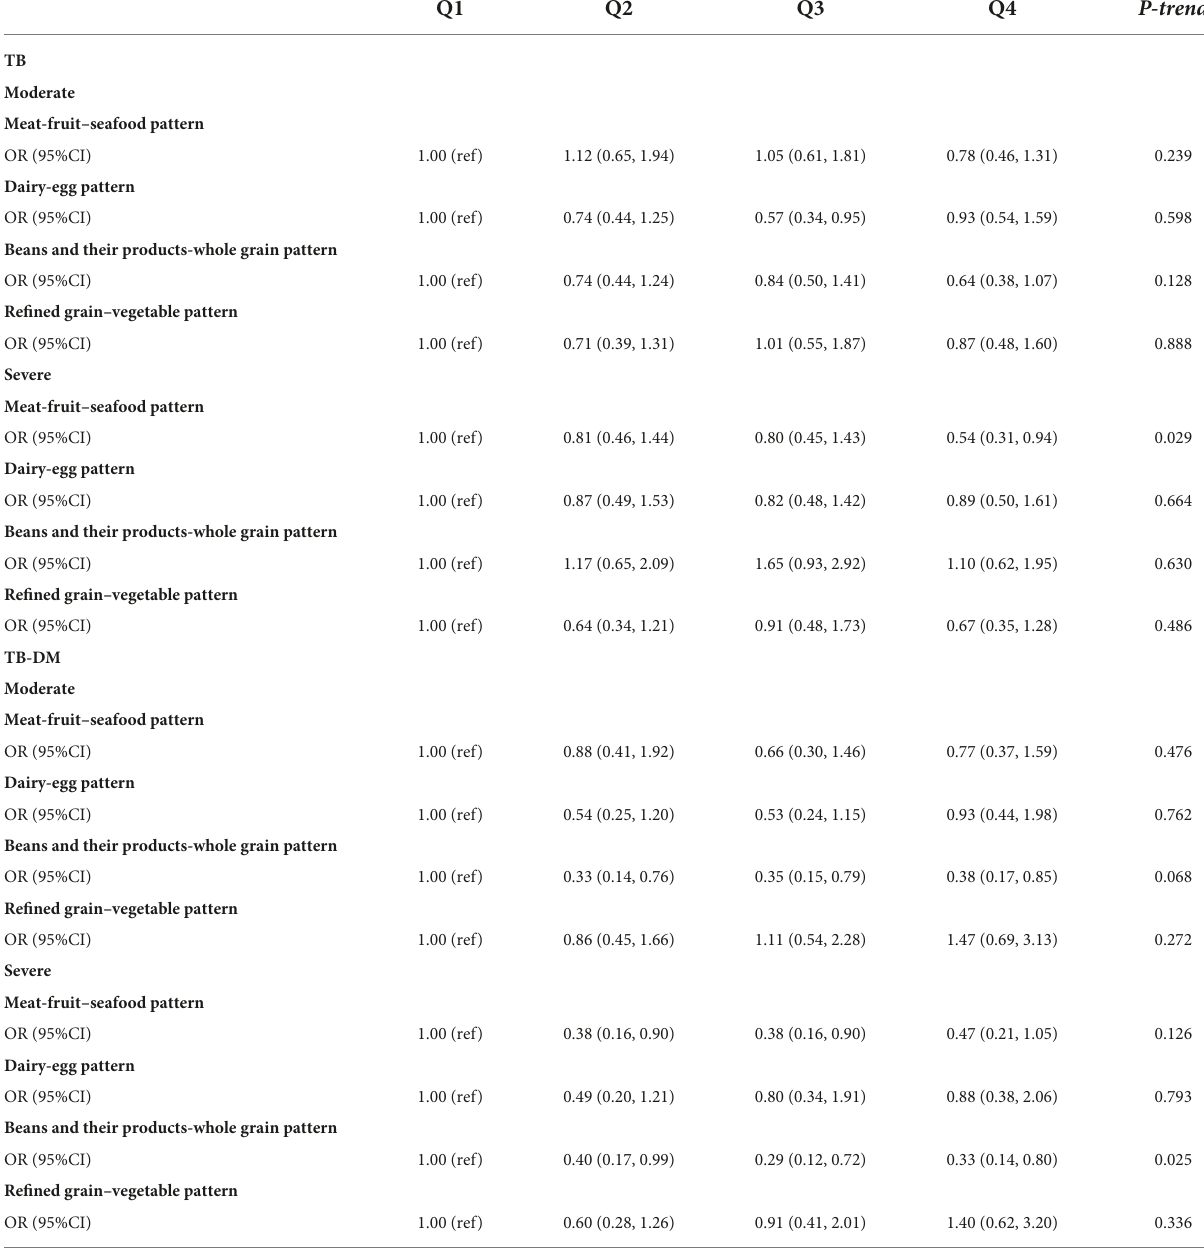
TABLE 5 Associations between dietary pattern score quartile and initial clinical manifestations, stratified by concurrent diabetes. Q1 Q2 Q3 Q4